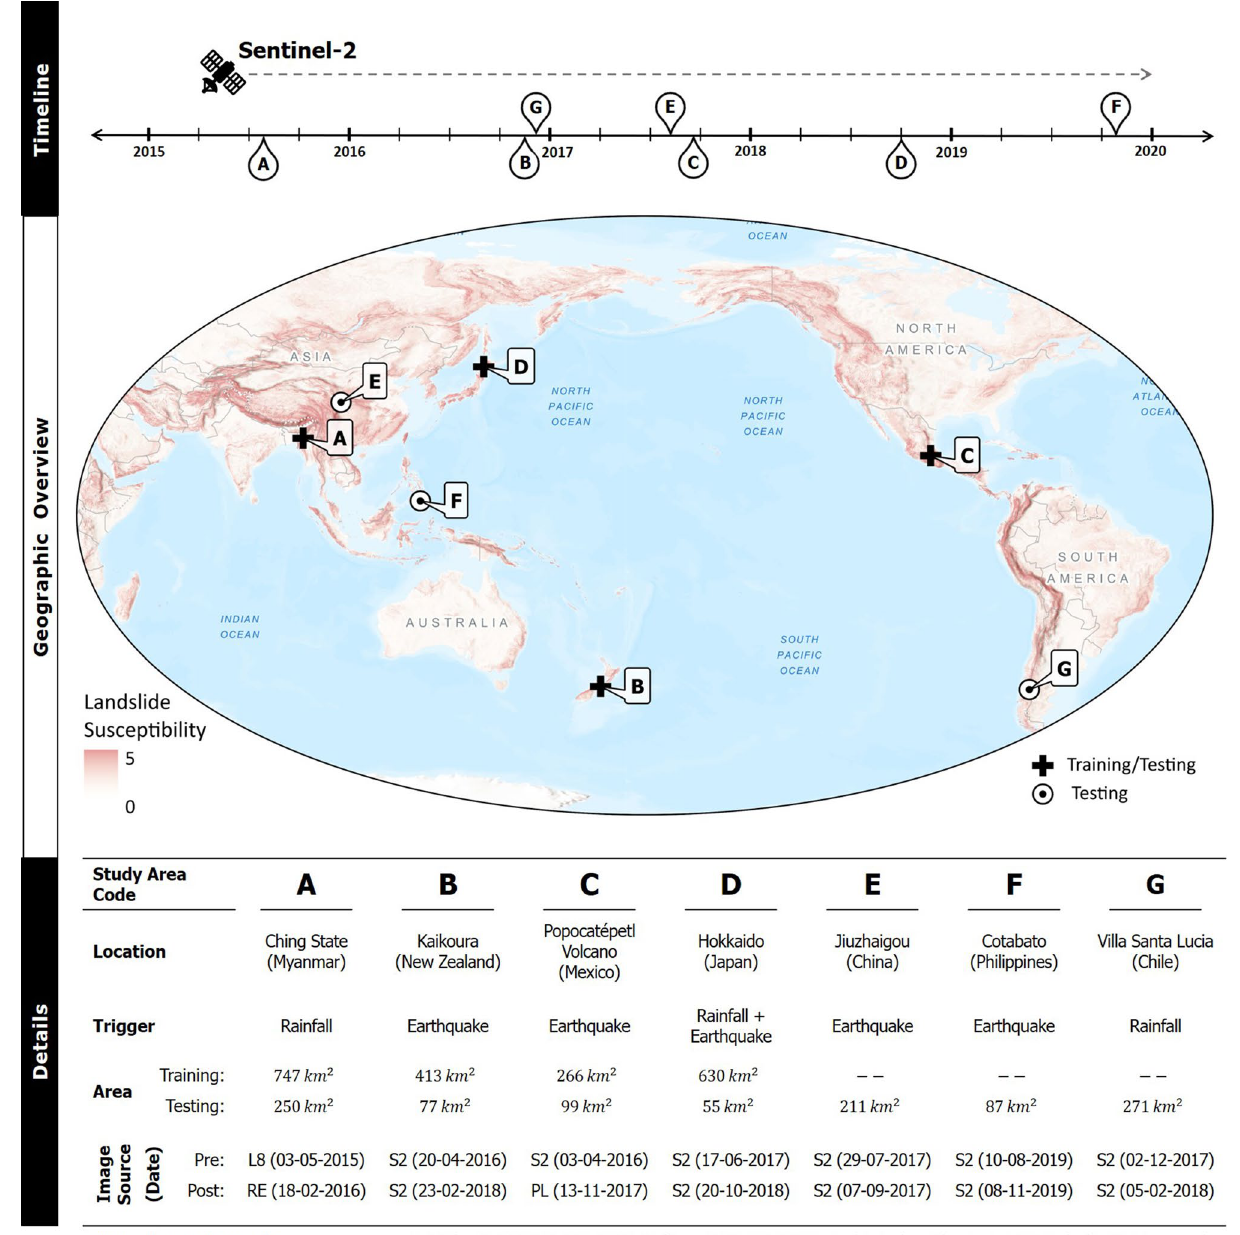
Figure 1. The map shows a geographic overview of the study areas over a background of global landslide susceptibility 51 . They are located around the Pacific Ocean, which is a seismically active zone with a high hydrological hazard distribution 52 . The approximate date of occurrence for the events are marked on a timeline (top). More details on the type of trigger, area of coverage, and optical data used for landslide mapping are presented in the table (bottom). Only study areas A to D will be used for training the CNN models in this work. The magnitude-frequency for all the landslide inventories is shown in Supplementary Figure 1. The map was created using ArcGIS Pro v2.4 (https:// www. esri.